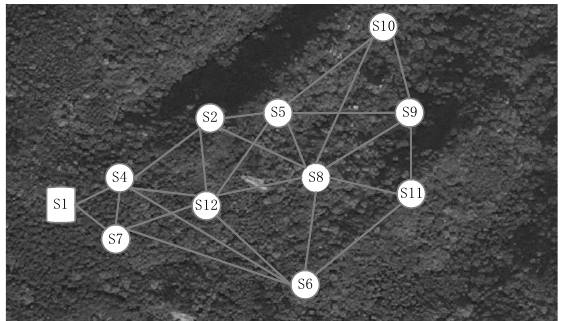
Figure 13. Overview of a ten-node wireless sensor network deployed in the Jiufeng forest (only a part of the wireless links is shown here for